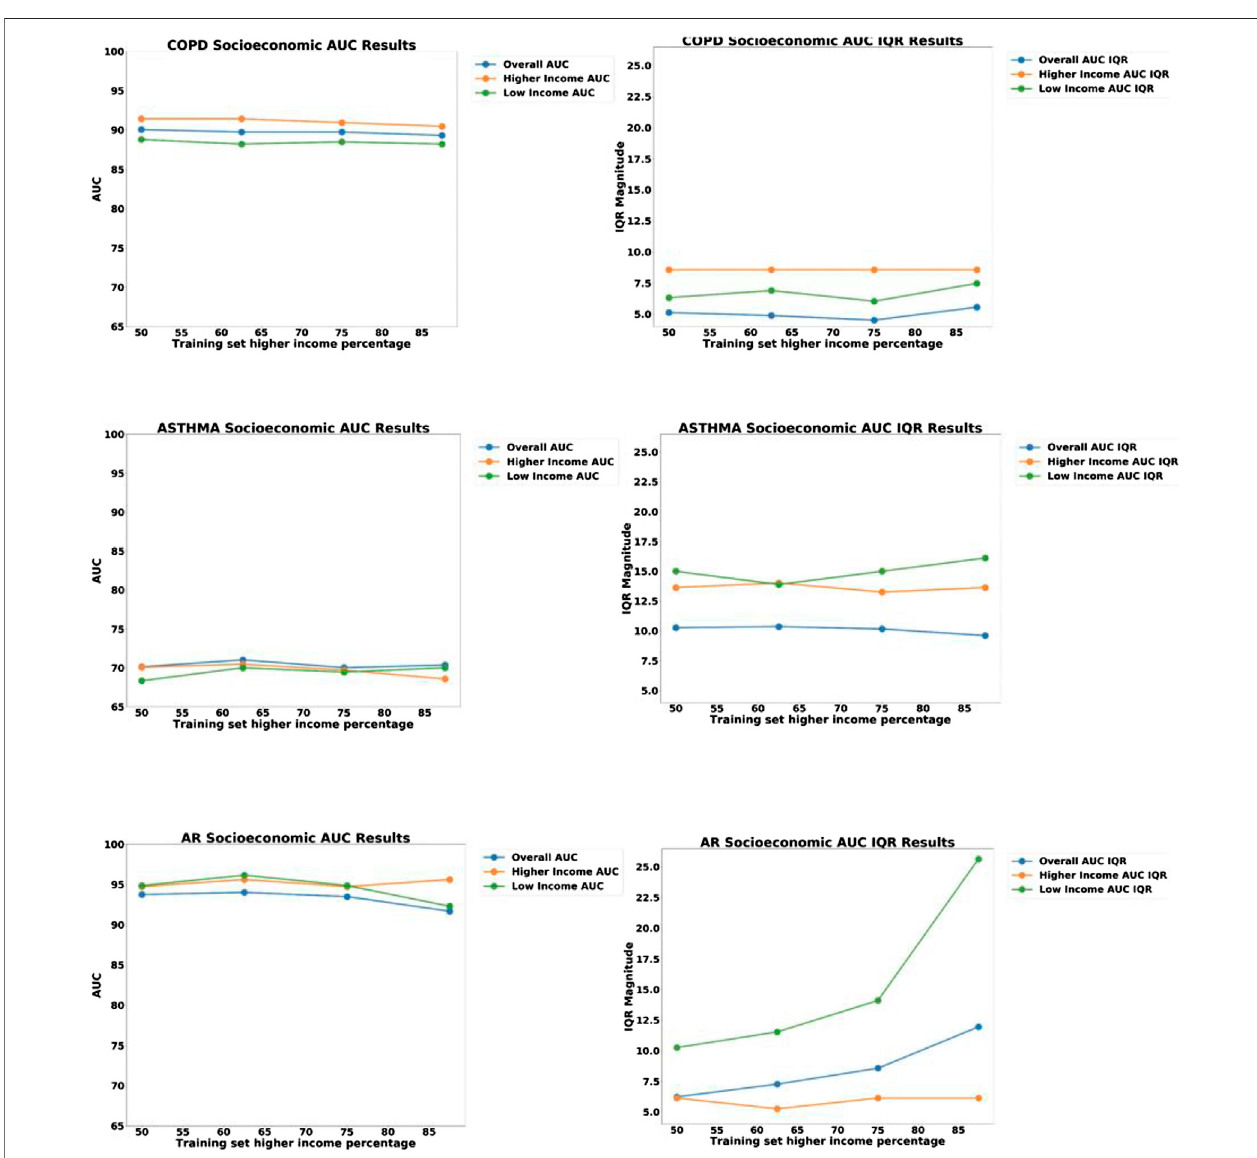
FIGURE 9 | Plots of AUC Accuracy (left) and InterQuartile Range (right) results of Socio-economic (SES) bias analysis for three different disease diagnostic models: (top) COPD; (middle) Asthma; and (bottom) Allergic Rhinitis (AR). The three colored lines in each plot represent the AUC accuracy for: all groups, High-SES only, and Low-SES only, respectively. The horizontal axis represents the proportion of high-SES patients in the training set, ranging from 50to